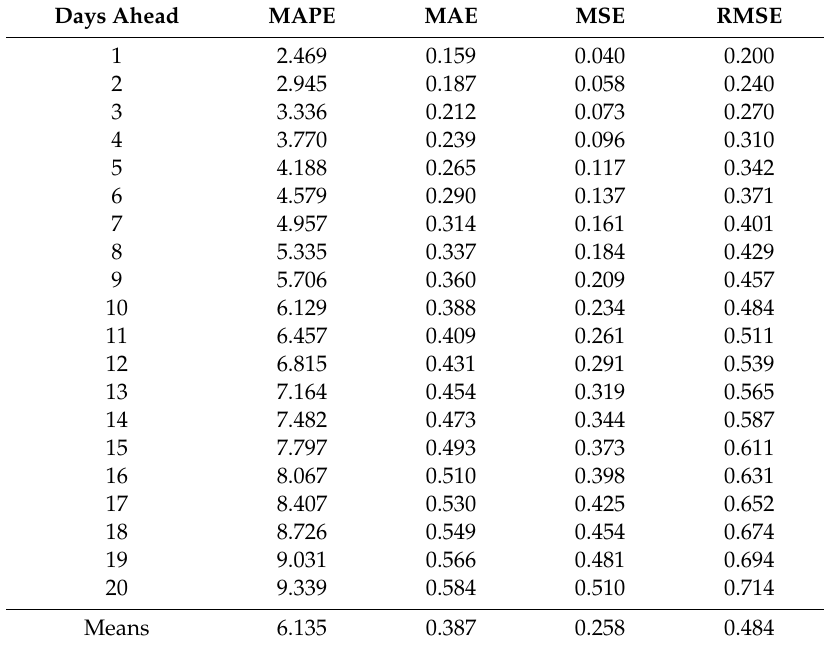
Table 3. Prediction errors of prices of CO 2 emission allowances when only past values were used as network